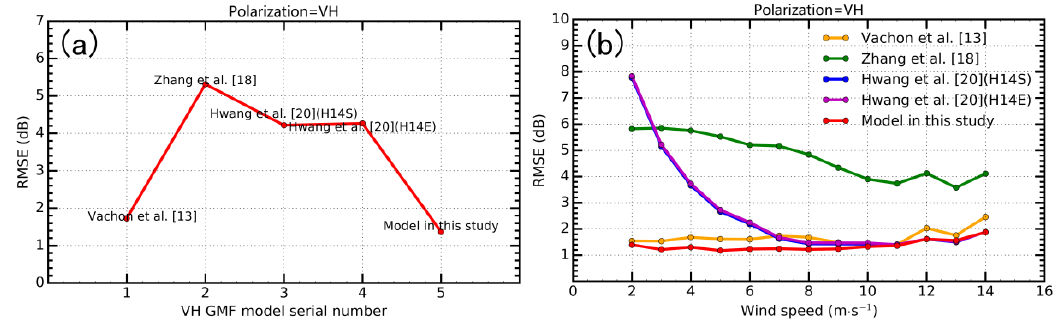
Figure 12. Same as Figure 6, but for VH polarization. The GMFs used include four previous models and one model developed using GF-3 data.